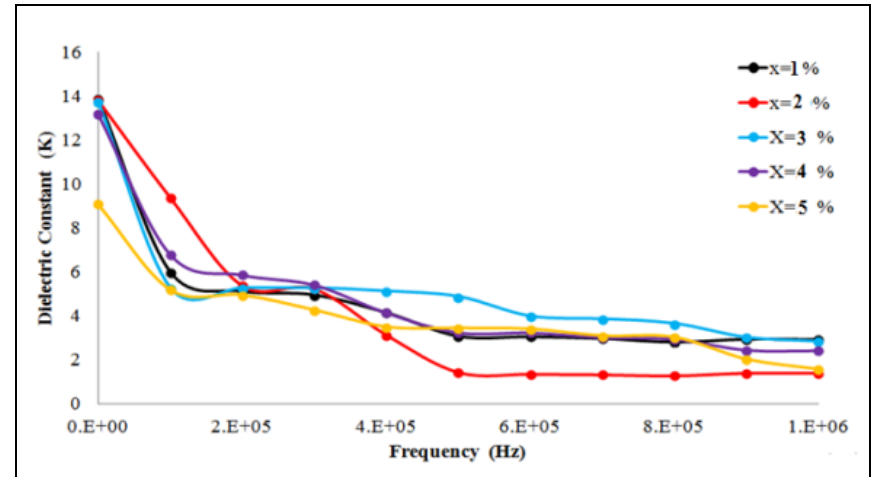
Fig.7: The (K) values with frequencies for composites (unsaturated polyester resin with